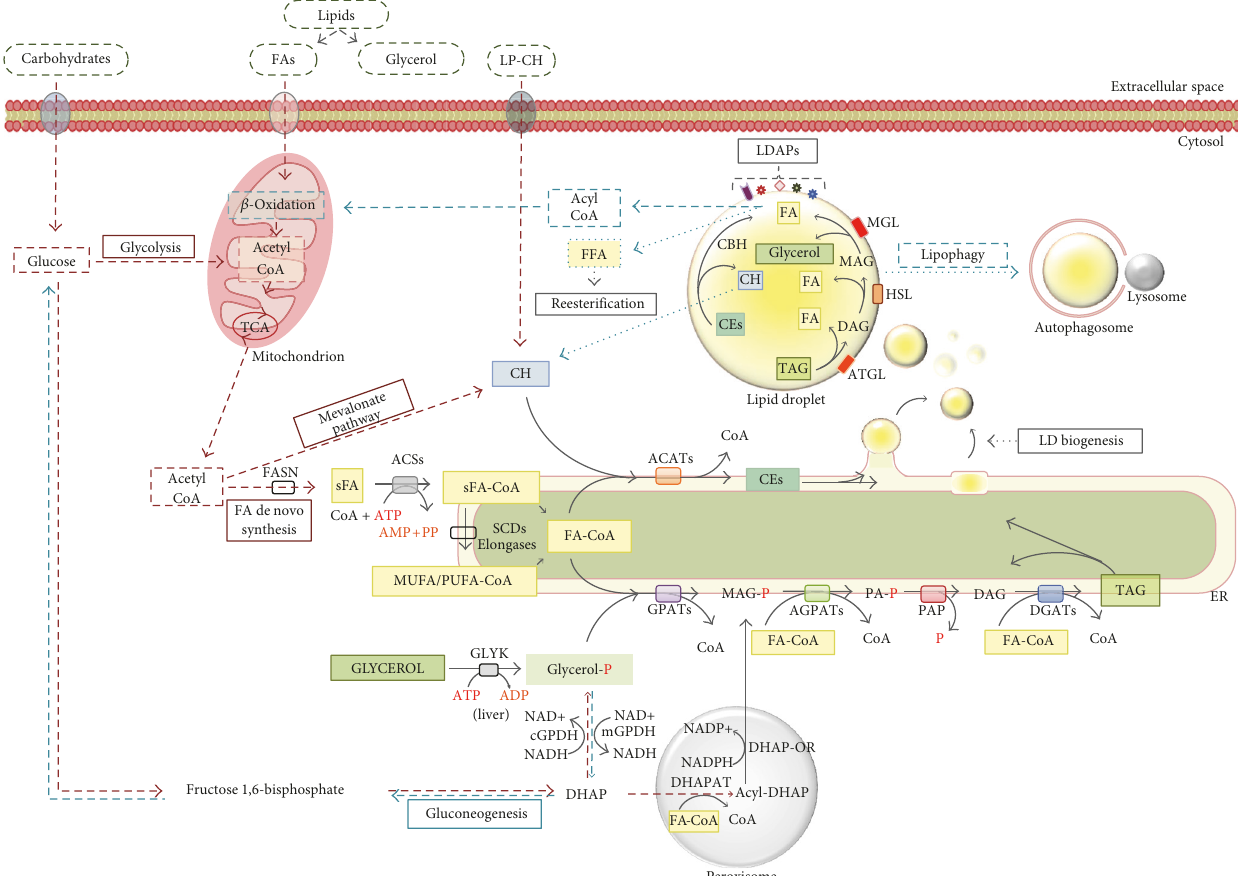
Figure 2: Schematic overview of the metabolic pathways required for the de novo synthesis of triacylglycerols and their lipolysis. Simpli fi ed representations of de novo FA synthesis and LD biogenesis are also included. FA-coA and MUFA/PUFA-coA are in general referred to as FA-CoA. AMP: adenosine monophosphate; ATP: adenosine triphosphate; ACATs: acyl-coA:cholesterol acyltransferases; ACS: acyl-coA synthetase; AGPATs: 1-acyl-glycerol-3-phosphate acyltransferases; ATGL: adipose tissue triacylglycerol lipase; CEH: cholesteryl ester hydrolase; CEs: cholesteryl esters; CoA: coenzyme A; DAG: diacylglycerol; DGAT: diacylglycerol acyltransferase; DHAP: dihydroxyacetone phosphate; DHAP-OR: dihydroxyacetone phosphate oxidoreductase; DHAPAT: dihydroxyacetone phosphate acyltransferase; ER: endoplasmic reticulum; FA: fatty acid; FA-CoA: fatty acyl-coenzyme A; FFA: free fatty acid; sFA: saturated FA; FASN: fatty acid synthase; GLYK: glycerol kinase; GPATs: glycerol-3-phosphate acyltransferases; cGPDH: cytosolic glycerol-3-phosphate dehydrogenase; mGPDH: mitochondrial glycerol-3-phosphate dehydrogenase; HSL: hormone-sensitive lipase; LDAPs: lipid droplet-associated proteins; LP-CH: lipoprotein involved in transporting cholesterol; MAG: 1-acylglycerols; MGL: monoacylglycerol lipase; MUFA: monounsaturated FA; NAD: nicotinamide adenine dinucleotide; NADH: reduced nicotinamide adenine dinucleotide; NADP: nicotinamide adenine dinucleotide phosphate; NADPH: reduced nicotinamide adenine dinucleotide phosphate; P: phosphate; PA-P: phosphatidic acid; PAP: phosphatidic acid phosphatase; PUFA: polyunsaturated FA; SCDs: stearoyl-CoA desaturases; TAG: triacylglycerol; TCA: tricarboxylic acid